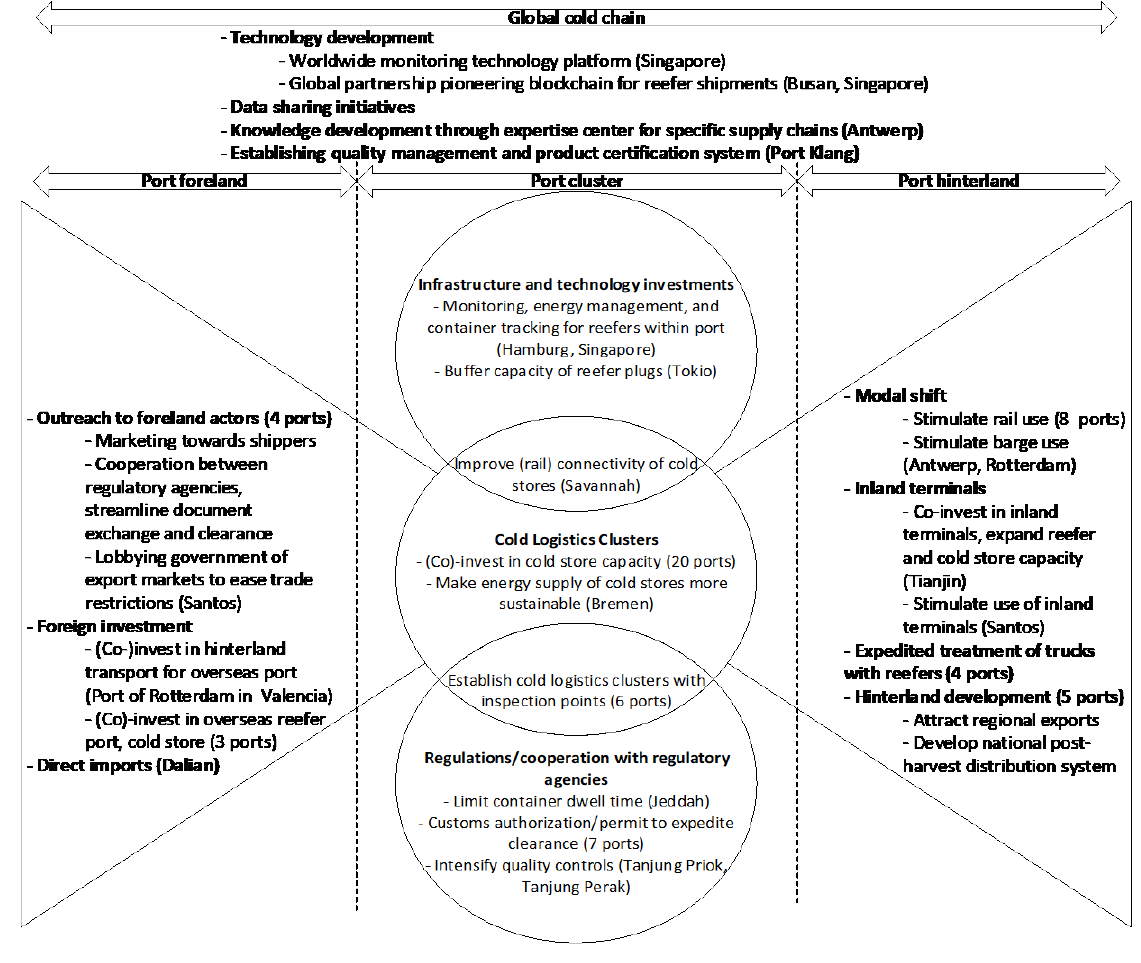
Figure 3. Schematic overview of the full spectrum of port policies for cold chains Policies for the port